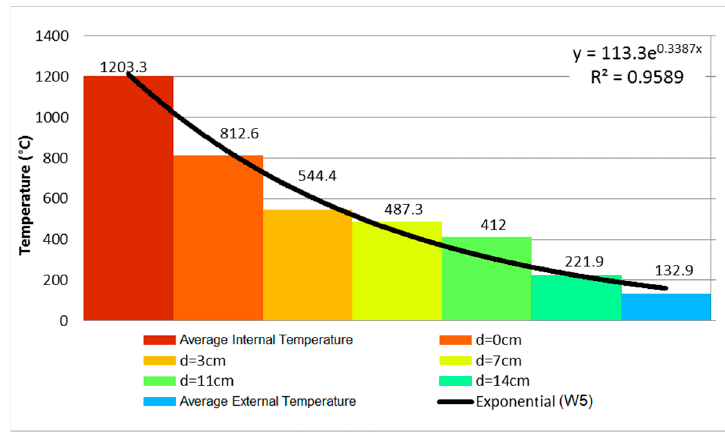
Figure 16. Temperature profile at 240 min—W5.